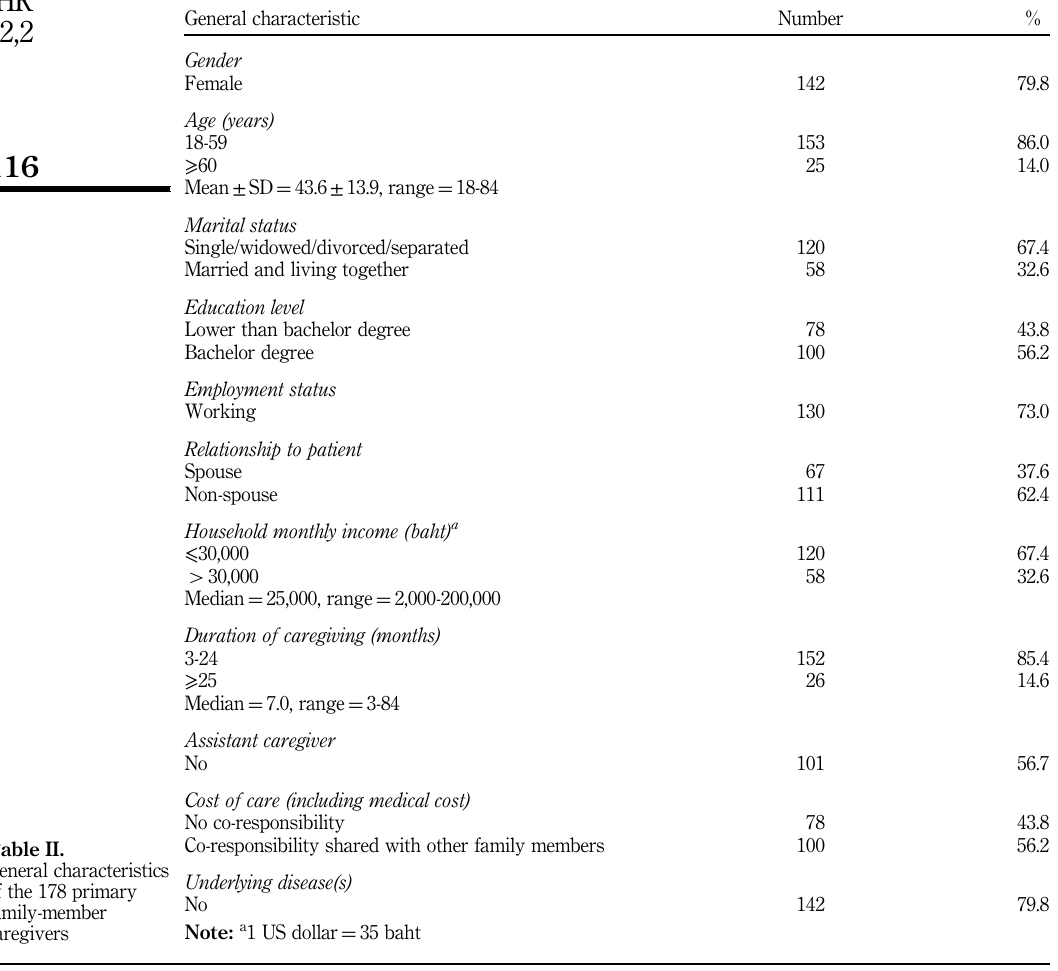
Table III. Mean scores, standard deviation and range of a Thai translation of the CQOLC, modified perceived self-efficacy and modified perceived social support among the 178 primary family- member